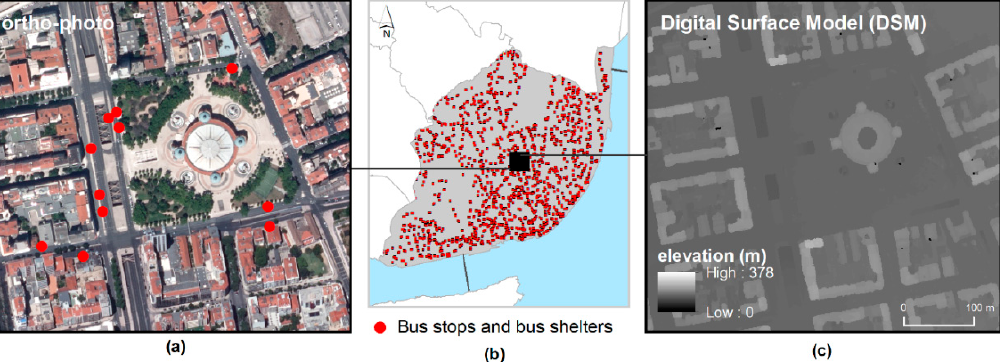
Figure 2. Datasets used for studying bus shelters’ photovoltaic (PV) potential: ortho-photo ( a ), bus stops and bus shelters ( b ) and Digital Surface Model ( c ).